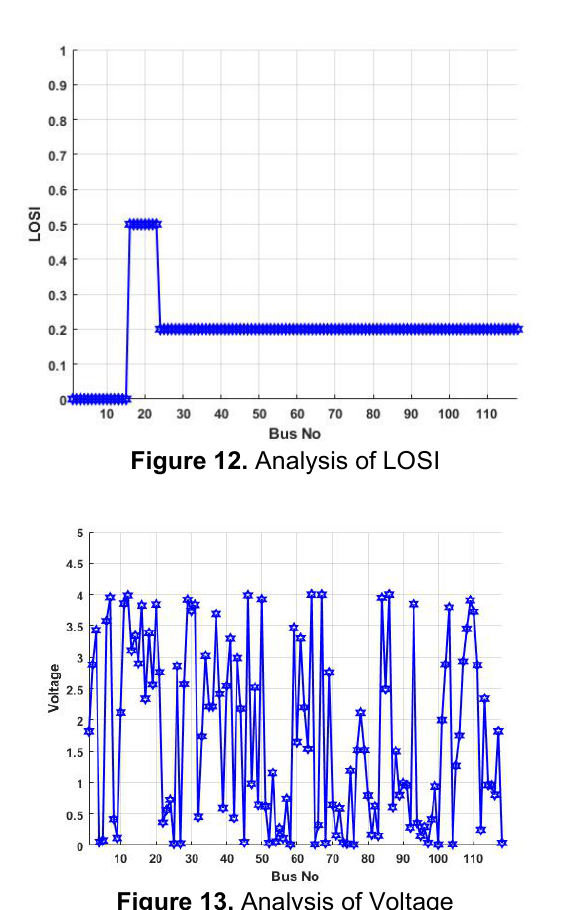
Figure 13. Analysis of Voltage